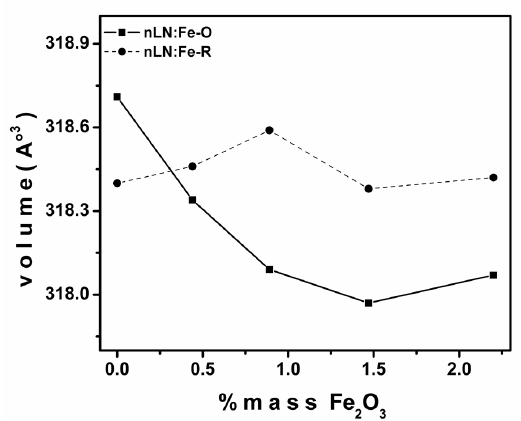
Figure 3. Cell volume as a function of % mass of Fe 2 O 3 . Oxidized and reduced samples are in black squares and circles, respectively. Table 1. Refined lattice parameters and cell volumes, along with relevant agreement indices Sample